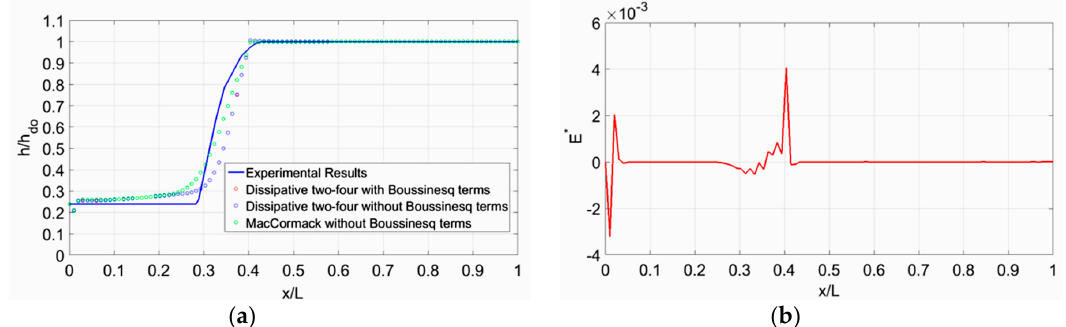
Figure 3. Experimental and Numerical Results for test case 2: ( a ) Free surface profile; ( b ) Boussinesq term versus distance.